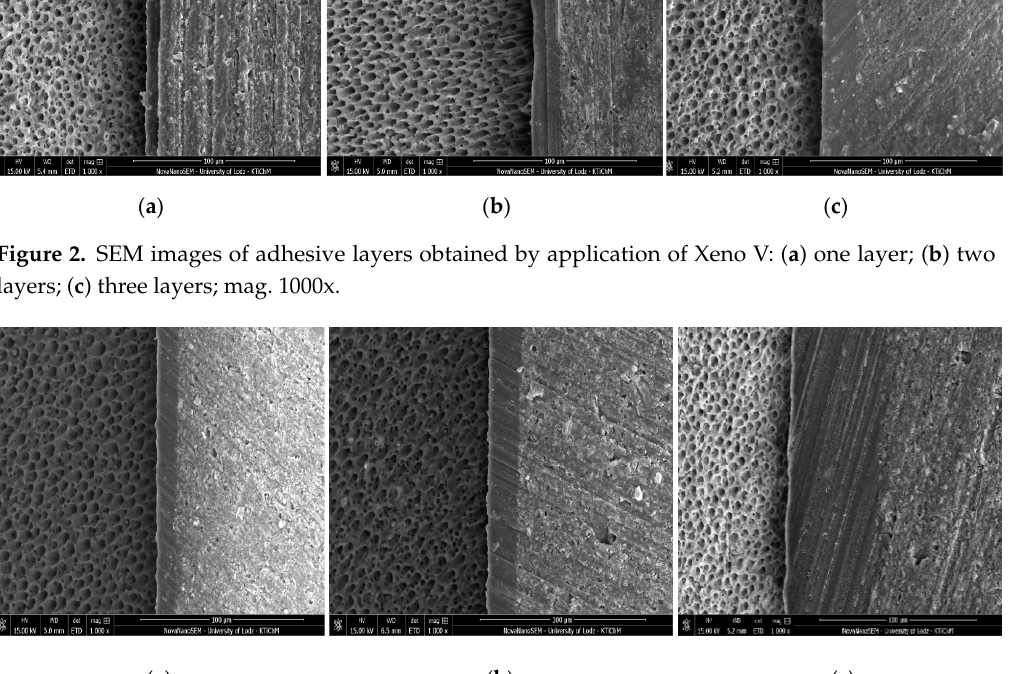
( c ) Figure 4. SEM images of adhesive layers obtained by application of Prime&Bond One Select: ( a ) one layer; ( b ) two layers; ( c ) three layers; mag. 1000x. The mean values of adhesive layer thickness measured for the tested adhesives are presented in Table 1. The thinnest adhesive layer was obtained for Xeno V applied in 1 layer (control) and the thickest was for Single Bond Universal applied in 3 layers. Table 1. Adhesive layer thickness [µm] (mean values ± standard deviation) of the tested adhesives. Adhesive